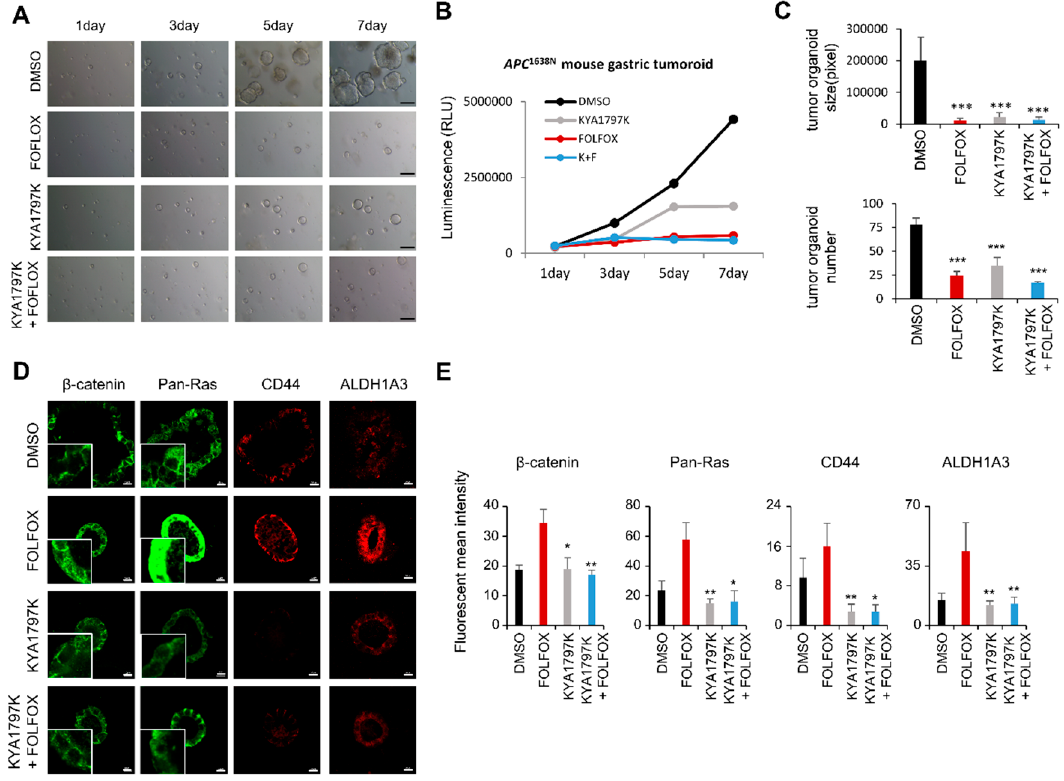
Figure 4. E ff ects of FOLFOX and KYA1797K on tumoroids from Apc 1638N mouse. Organoids derived from single Apc 1638N mouse tumor cells were dissociated and maintained every 7–10 days. ( A ) The e ff ects of FOLFOX (5-fluorouracil at 10 µ g / mL and oxaliplatin at 1 µ g / mL) and KYA1797K (25 µ M) on APC 1638N mouse tumor-derived organoids (passage n = 6) were tested for 7 days. Representative images were captured every two days. Scale bar = 200 µ m. ( B ) The number of viable cells was detected with reference to luminescence production (CellTiter-Glo ® Luminescent Cell Viability Assay, Madison, Wisconsin, USA). ( C ) The sizes and numbers of Apc 1638N mouse tumor-derived GC organoids in ( A ) were measured and quantified using the Image J program. Two-sided Student’s t -test was used to determine statistical significance. Error bars represent 95% confidence intervals ( n = 3). ( D ) Immunocytochemical (ICC) analyses were performed by using β -catenin, pan-Ras, CD44, or ALDH1A3 antibody. Organoids were counterstained with DAPI. Boxes indicate the enlarged area, and dash line indicates the nucleus. Original photos with DAPI are shown in Supporting Information Figure S5. Images were captured using a Zeiss confocal microscope. Scale bar = 10 µ m. ( E ) Mean fluorescence intensities of the markers were quantified for at least three di ff erent tumoroids using NIS-Elements AR 3.1 (Nikon; Melville, New York, USA). * q < 0.05, ** q < 0.005, *** q < 0.0005 versus